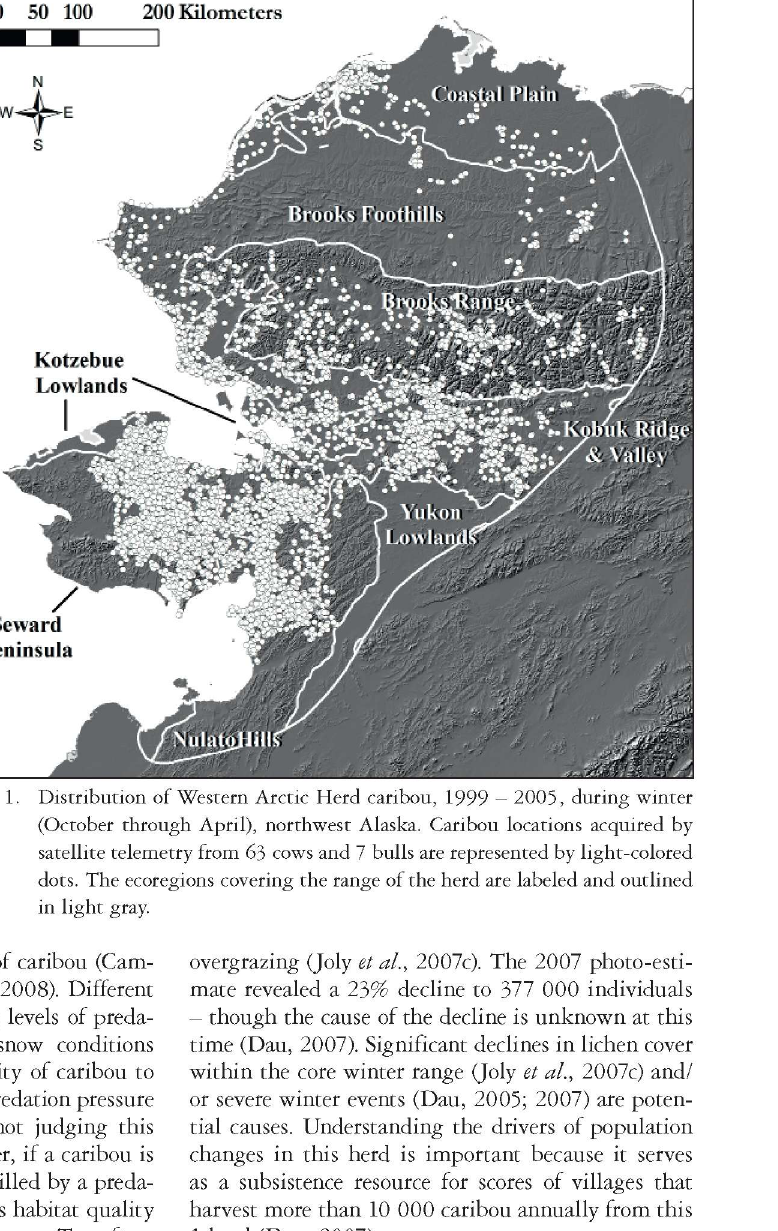
Fig. 1. Distribution of Western Arctic Herd caribou, 1999 — 2005, during winter (October through April), northwest Alaska. Caribou locations acquired by satellite telemetry from 63 cows and 7 bulls are represented by light-colored dots. The ecoregions covering the range of the herd are labeled and outlined in light